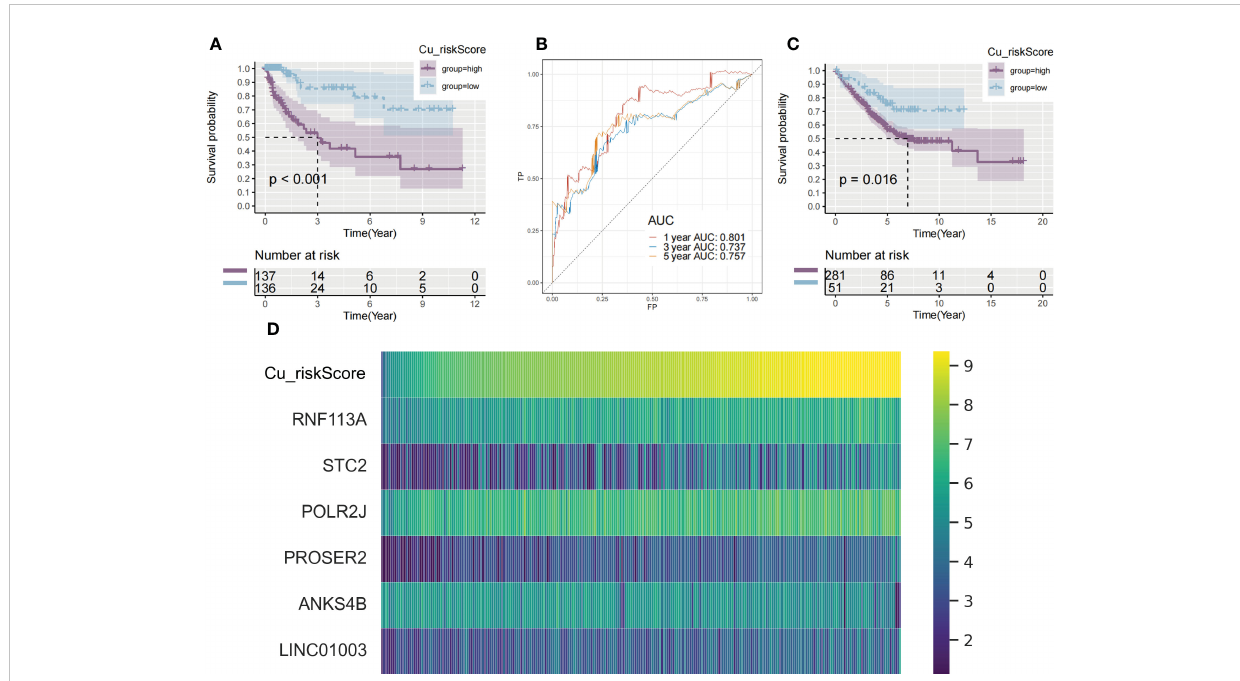
FIGURE 2 Identi fi cation of cuproplasia signature in TCGA and GEO. (A) The Kaplan-Meier survival analysis of the Cu_riskScore high and the Cu_riskScore low groups in the TCGA dataset, respectively. (B) ROC curve evaluating the value of Cu_riskScore in predicting the patient's 1-, 3-, and 5-year survival status. (C) The Kaplan-Meier survival analysis of the Cu_riskScore high and the Cu_riskScore low groups in the GEO dataset, respectively. (D) Heatmap showing the expression of 6 Cu_riskScore composing genes with increasing Cu_riskScore.